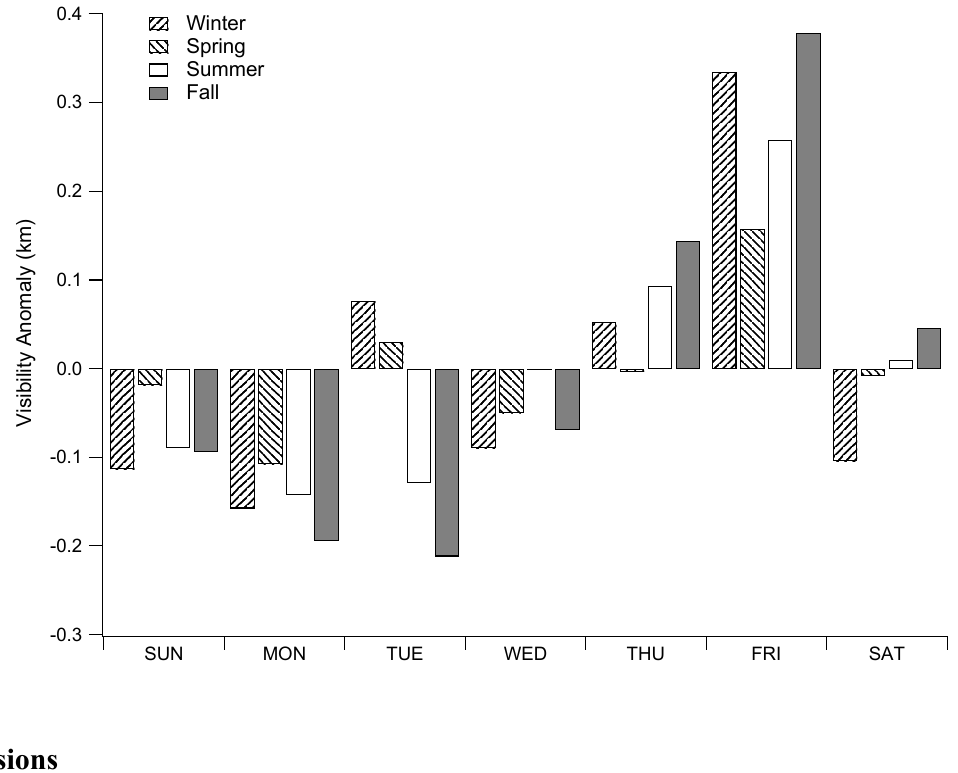
Figure 9. Average visibility anomaly in Tehran (Mehrabad) filtered by day-of-week for each season of the year. The visibility anomaly is calculated as the average deviation for each day-of-week from the climatological mean for each season. Note that the weekend in the study region is Friday, although some industries also observe Thursday as a reduced working